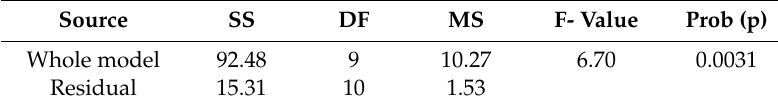
Table 6. Analysis of variance (ANOVA) for the quadratic